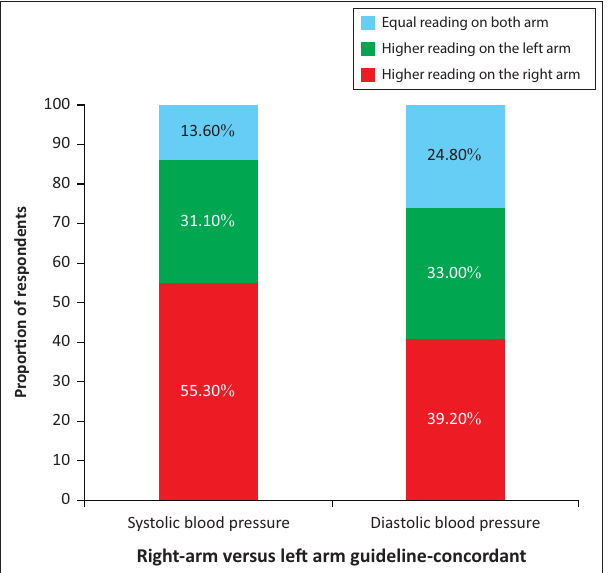
FIGURE 1: Guideline-concordant systolic and diastolic blood pressure measurement of both arms.